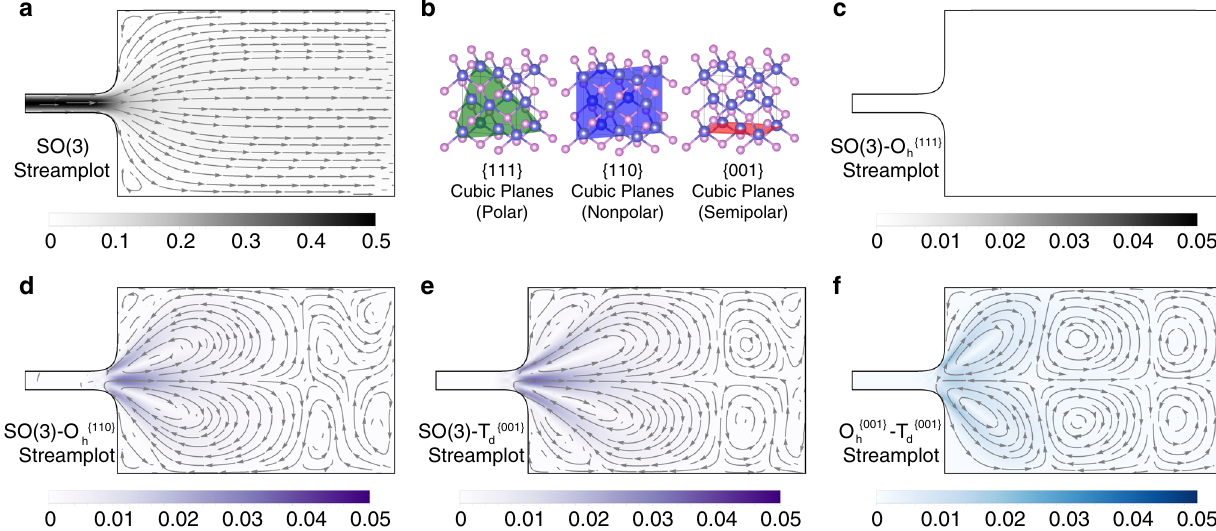
Fig. 3 Three-dimensional projected fl ows through an expanding geometry. a Steady-state streamplot using an isotropic (SO(3)) viscosity tensor. b High- symmetry family of planes in cubic crystals. In crystals with T d (tetrahedral) symmetry, these are further identi fi ed as polar {111}, nonpolar {110}, and semipolar {001}. Difference in the steady-state streamplot between using an isotropic viscosity tensor and using c (111)-projected, d (110)-projected, and e (001)-projected viscosity tensors of cubic crystals with T d symmetry. Note that c shows no difference. f Effect of viscosity tensor asymmetry difference between O h and T d crystals along a semipolar {001} plane. Color scales indicate the magnitude of the velocity vector fi case. Finally, along the semipolar {001} family of planes, the viscosity tensor is both anisotropic (Fig. 3e) and asymmetric. Figure 3f quanti fi es the additional vortices generated by the ¼ 0 and Γ = 0.25. asymmetry at ~10%, for B 5 5